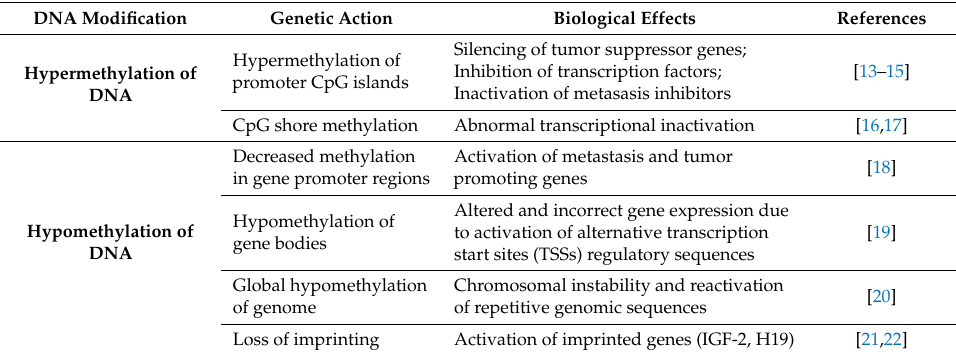
Table 1. Aberrant DNA methylation profiles occurring in